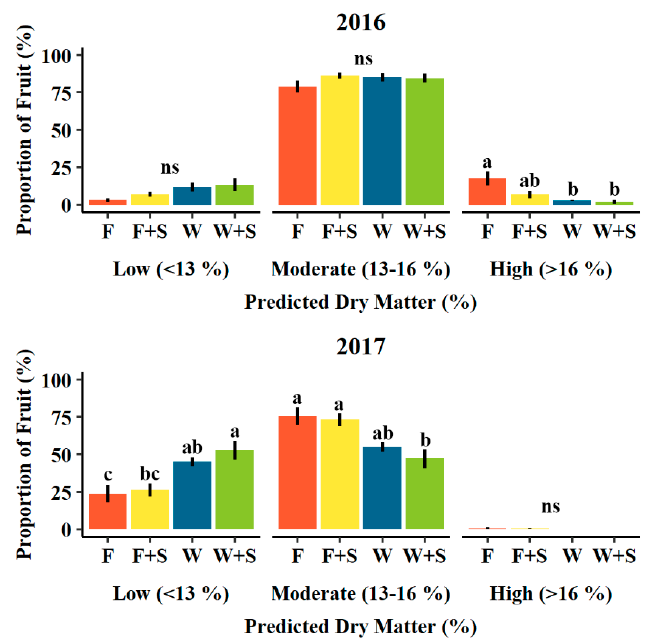
Figure 6. Mean proportion of low (<13%), moderate (13–16%), and high (>16%) predicted dry matter classes of pears determined at harvest in 2016 (upper), 2017 (lower) among seasonal pruning treatments consisting of fall pruning (F, orange, n = 512 and 320 in 2016 and 2017, respectively), fall and summer pruning (F+S, yellow, n = 501 and 320 in 2016 and 2017, respectively), winter pruning (W, blue, n = 500 and 320 in 2016 and 2017, respectively), and winter and summer pruning (W+S, green, n = 500 and 320 in 2016 and 2017, respectively). Error bars indicate ± standard error. Different letters indicate significance difference among means ( p < 0.05, Tukey HSD). “ns” indicates no significant difference among means ( p > 0.05, Tukey HSD).